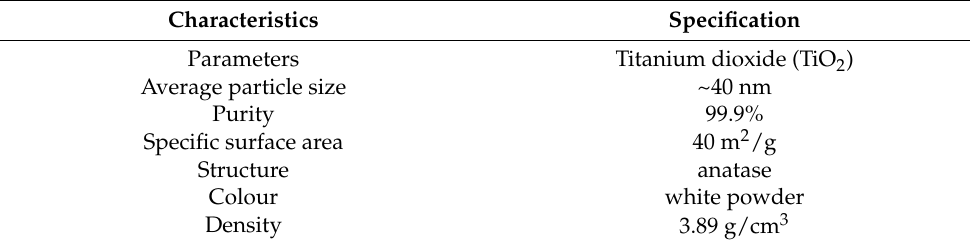
Table 1. The main properties of TiO 2 nanomaterial used to coat porcelain insulators are listed.